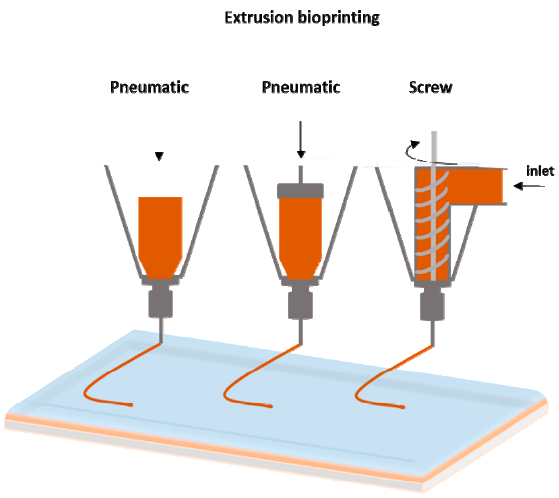
Figure 3. Schematic representation of extrusion bioprinting.